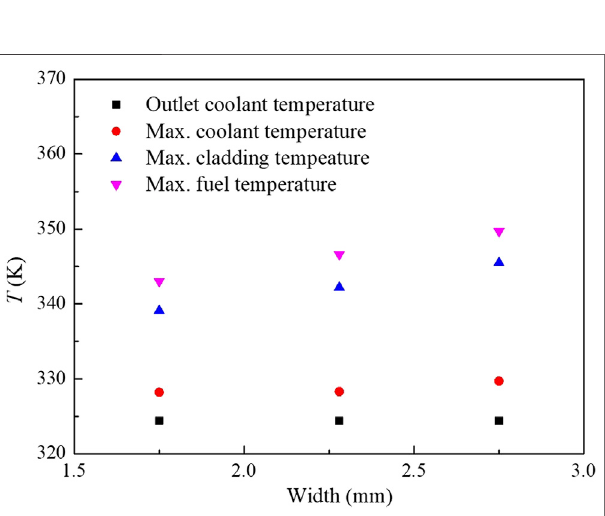
Frontiers in Energy Research |